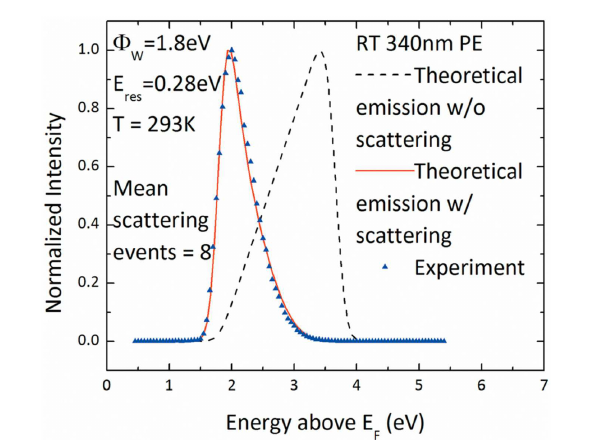
FIGURE 5 | Normalized PEED from nitrogen-doped diamond films .The original theory is three-dimensional normal from Eq. 28 and convolved with the Gaussian instrument function.The theory without scattering has a much higher peak energy and broader distribution. Adding scatter by optical phonons leads to a closer fit to the experimental PEED. Reprinted with permission from Sun et al. (2011).